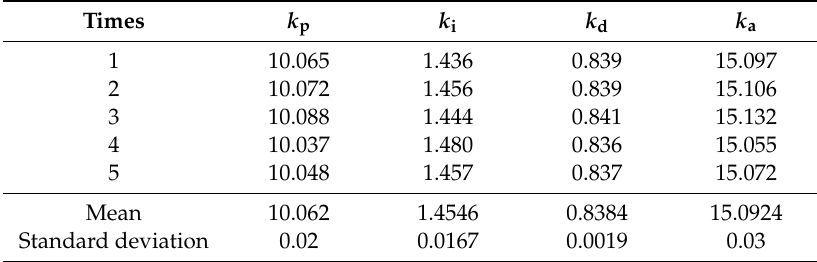
Table 1. Optimized controller parameters of desuperheater controller